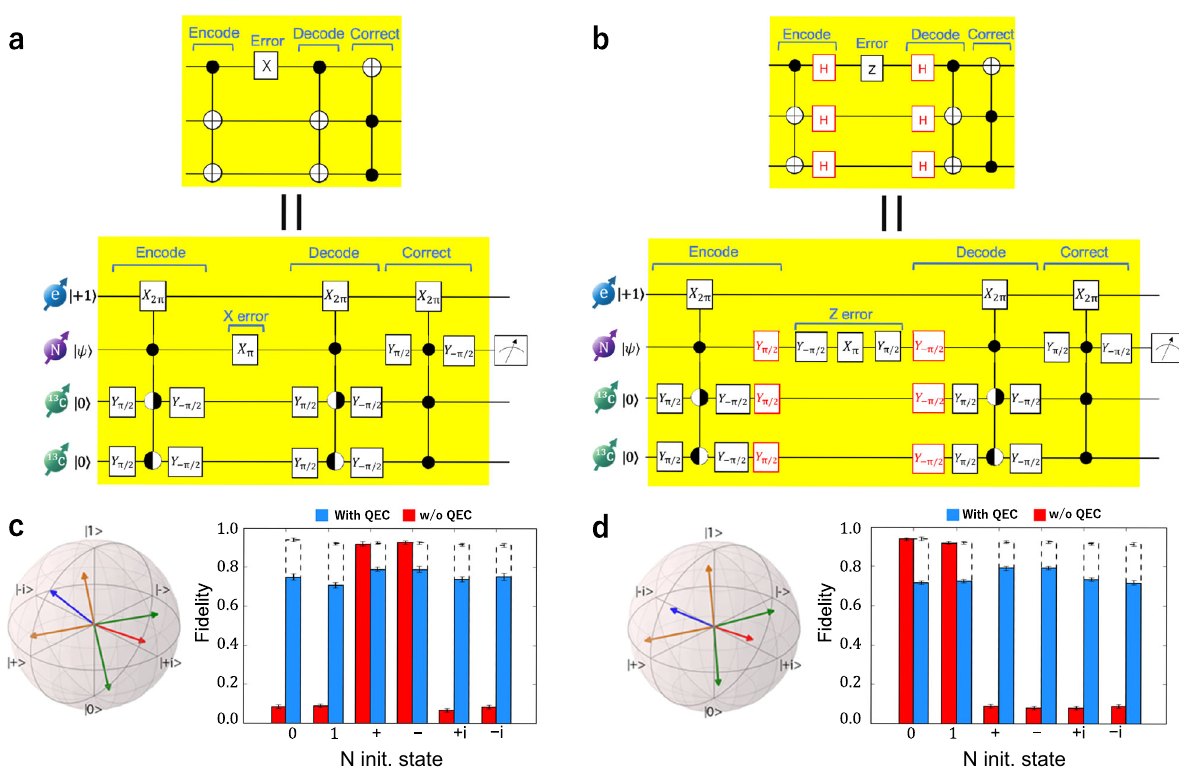
N init. state N init. state Fig. 3 QEC with three qubits. a , b Quantum circuit of three-qubit quantum error correction (QEC) for bit- fl ip ( a ) and phase- fl ip ( b ) errors. The phase- fl ip code ( b ) is the same as the bit- fl ip code ( a ) except for the Hadamard (H) gates inserted immediately after encoding and before decoding. X, Y, and Z, respectively, denote Pauli-X, Pauli-Y, and Pauli-Z gates. c , d Bloch sphere representation of nitrogen nuclear spin state by state tomography after the quantum error correction (QEC) against bit- fl ip ( c ) and phase- fl ip ( d ) errors (left) and the state fi delity of the nitrogen nuclear spin for six initialized states (right). The dotted lines represent the estimated fi delity when state preparation and measurement (SPAM) errors are included. Blue (red) bars represent experimental results with (without: w/o) QEC. Since the error does not affect the fi delity in the corresponding bases ({ + , − } in c and {0,1} in d ), there is no difference between with or without error and those fi delities are even higher without QEC. Error bars are de fi ned as the standard deviation of the photon shot